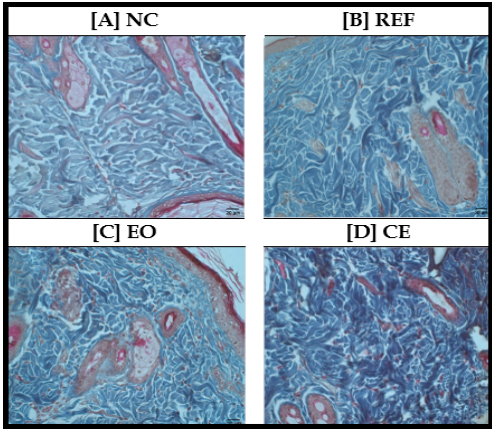
Figure 7. Histological sections of the wound tissue of rats after topical application of cream base ( A ), Fucidin cream ( B ), EO cream ( C ), and CE cream ( D ). Masson Trichrome stain, Magnification: ×400.